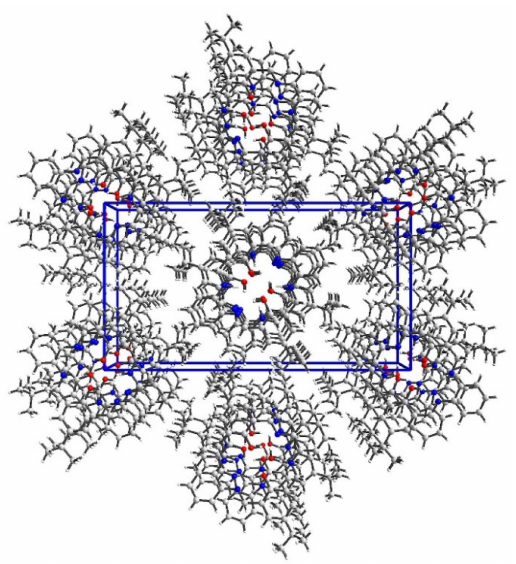
Figure 4. Perspective view of L2 along c axis shows a column composed of alternately arranged O14 and O34 molecules rotated by ca. 46 ◦